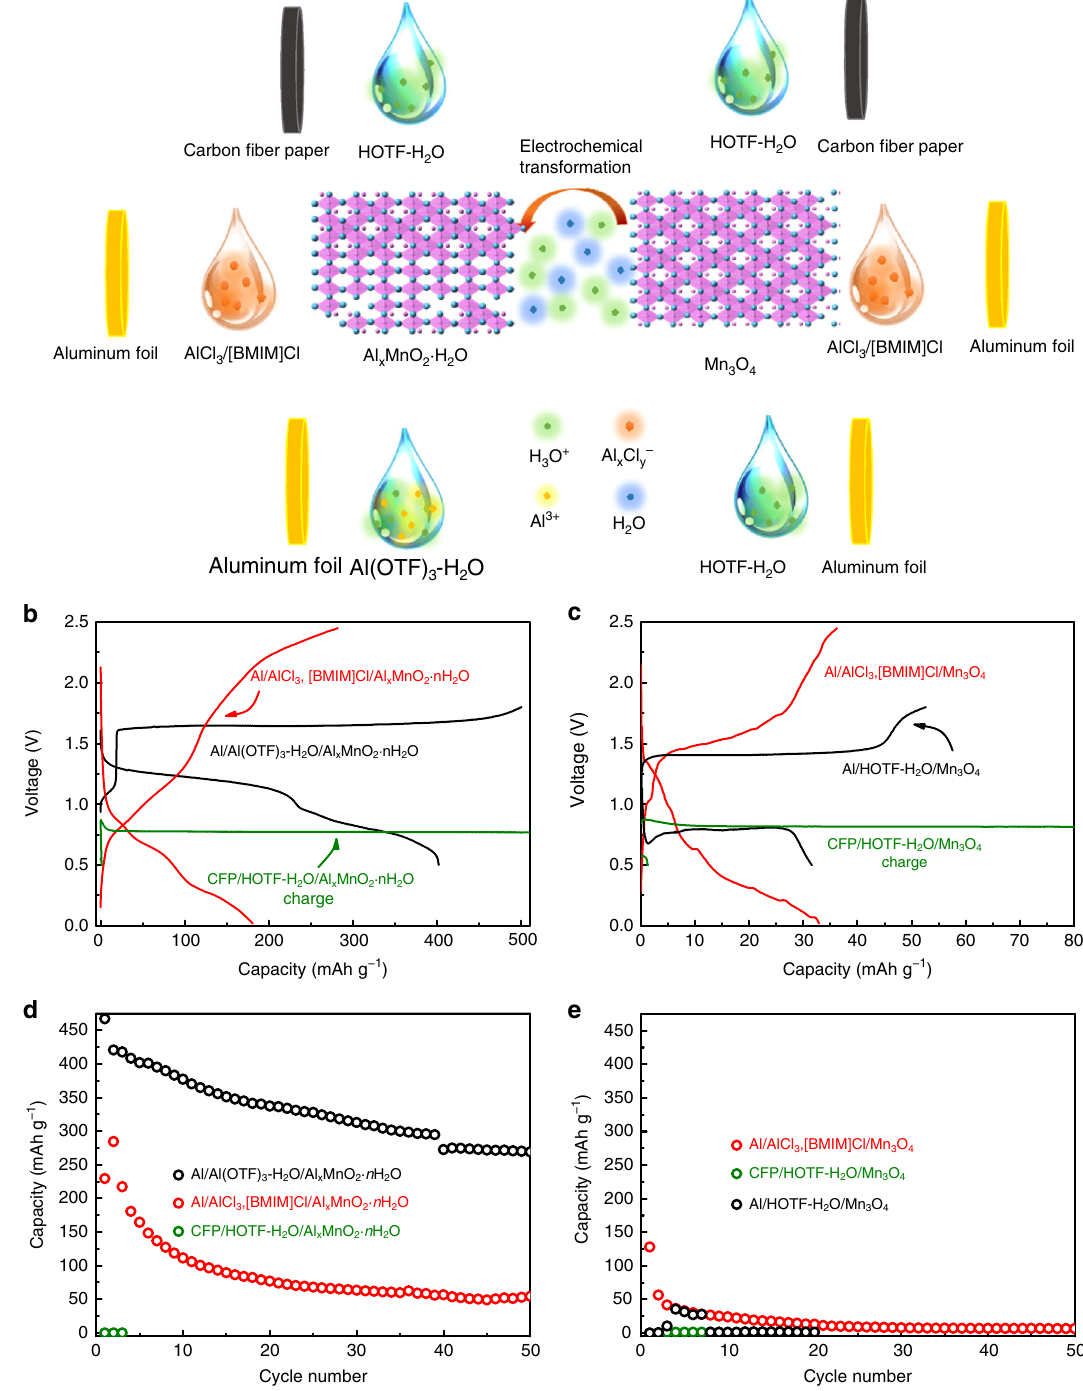
Fig. 5 The schematic diagram and results of comparative experiment. a The scheme of the control experiment, it displays the experiment design that the cathode Al x MnO 2 · n H 2 O and Mn 3 O 4 matches up with aqueous and ionic liquid electrolyte and counter anode respectively. b , d Typical charge and discharge of the different battery. c , e Discharge capacity of different